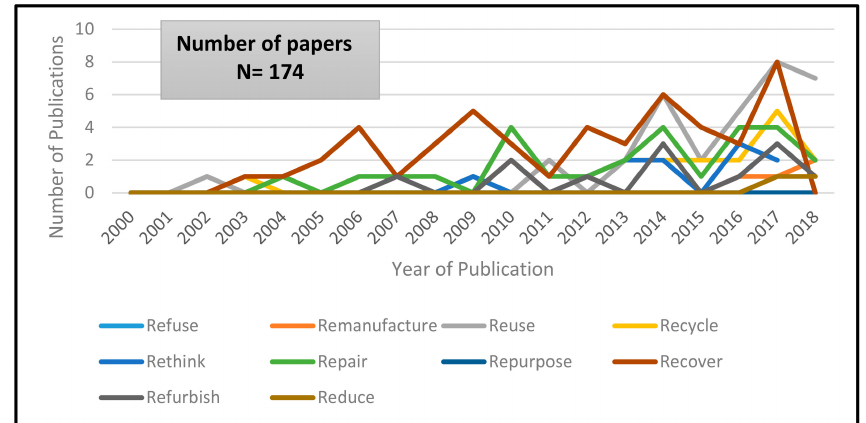
Figure 7. Number of Publications vs. Year of Publications for circular approaches and Industry